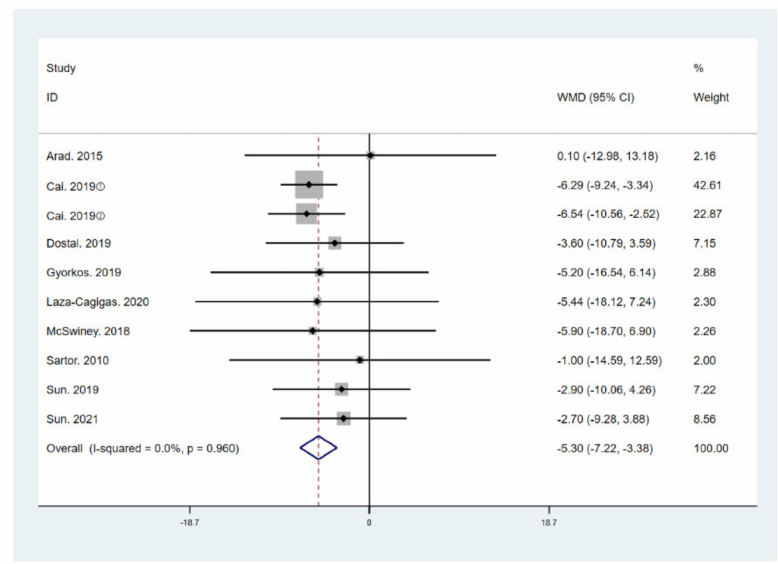
Figure 4. Forest plot for the effect of a low-carbohydrate high-fat (LCHF) diet combined with HIIT on body mass (BM). For each study, squares represent the mean difference in intervention effects, with horizontal lines intersecting them as the lower and upper limits of the 95% CI. The size of each square represents the relative weight of the studies conducted in the meta-analysis. The diamond represents the results of the meta-analysis combining the individual